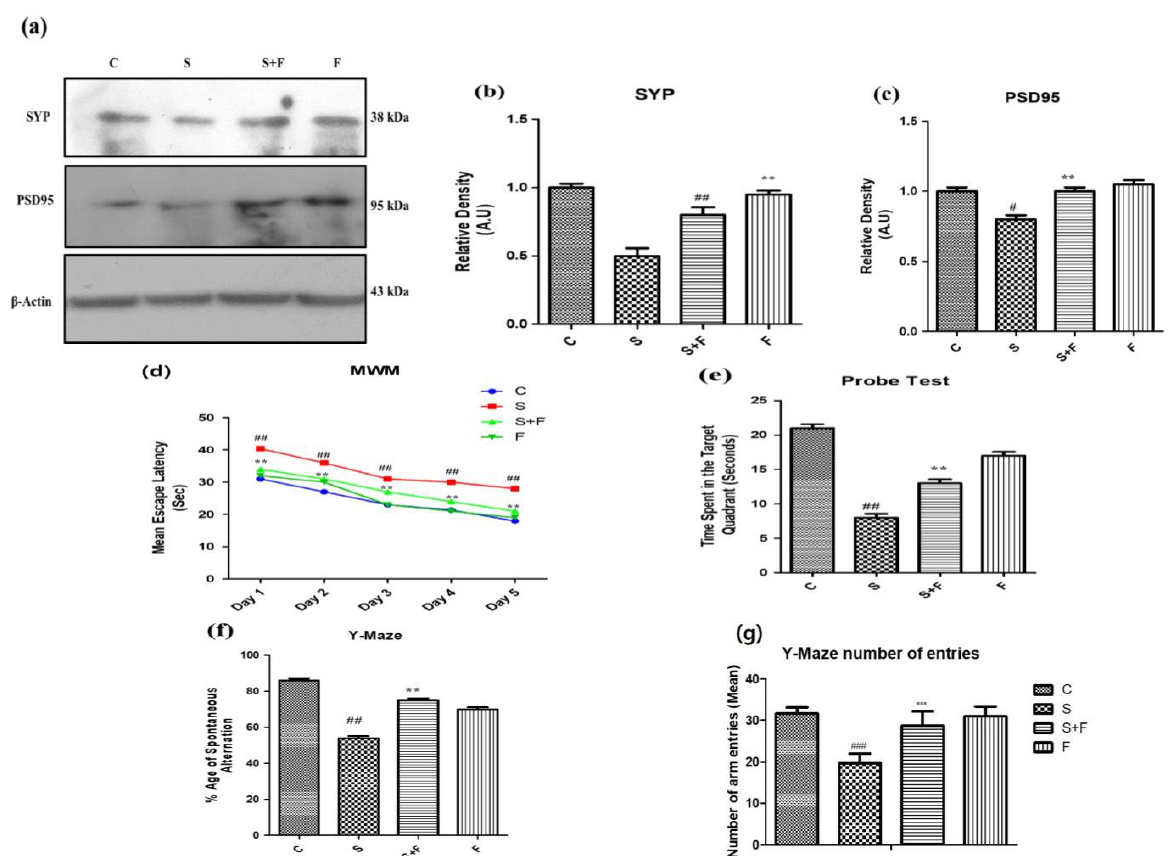
Figure 4. Friedelin improved pre and post synapse and memory dysfunction against scopolamine in mice. The up-regulation of SYP and PSD95 in response to administration of friedelin along with scopolamine in contrast to the control and scopolamine group is shown at ( a ), along with the histogram plot of respective relative densities ( b , c ). The results were expressed in arbitrary unit (A.U) and were determined using Image J software and histogram indicates mean in A.U ± SEM. While results of behavioral tests are given as ( d ) mean escape latency in MWM ( e ) probe test, ( f ) %age spontaneous alteration in Y-Maze test and ( g ) Y-Maze number of arm entries. Significance of control vs. scopolamine is expressed as # , while * denotes scopolamine vs. scopolamine + friedelin. Significance: # p < 0.05, ** , ## p < 0.01 and *** , ### p < 0.001.